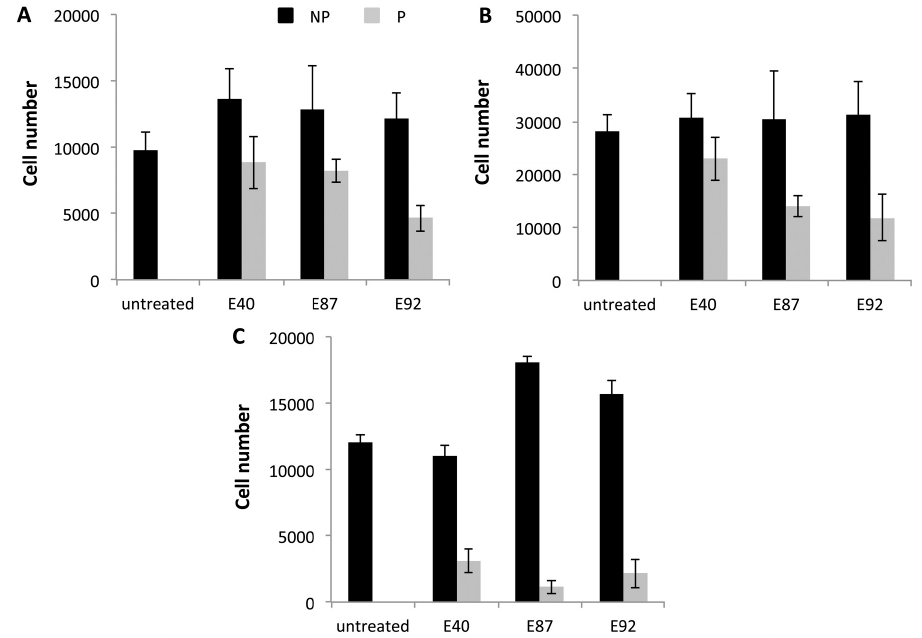
Figure A1. Cell viability assay of E40, E87 and E92 on human cancer cells. HepG2 ( A ); HeLa ( B ) and Hek293 ( C ) were treated for 48 h at 37 °C with 20% (corresponding to a concentration of phenolics ranging between 156 and 212 μ g/mL) extracts from E40, E87 and E92 before (black bars) and after (grey bars) heat treatment. Cell number was evaluated by trypan blue dye exclusion assay. All values are given as means ± SD.